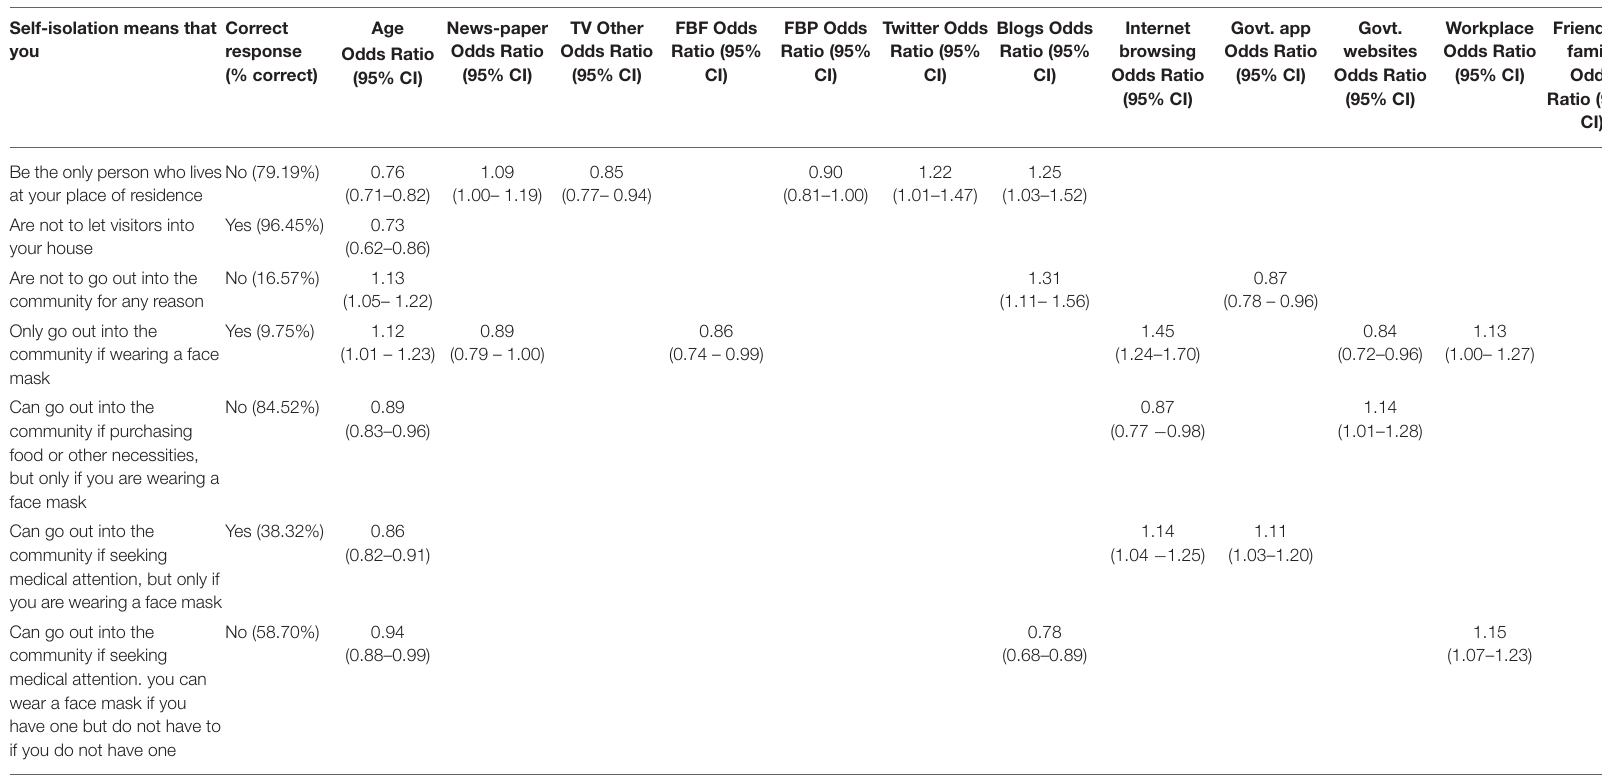
TABLE 2 | Factors (age and information sources) associated with correct responses to the questions regarding self-isolation. Self-isolation means that